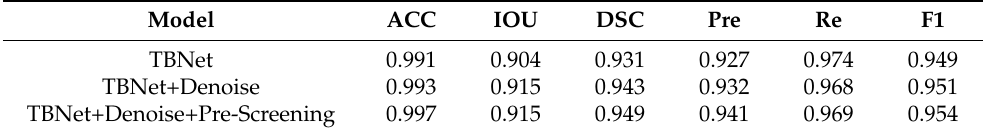
Table 3. Comparison of TBNet under different conditions.